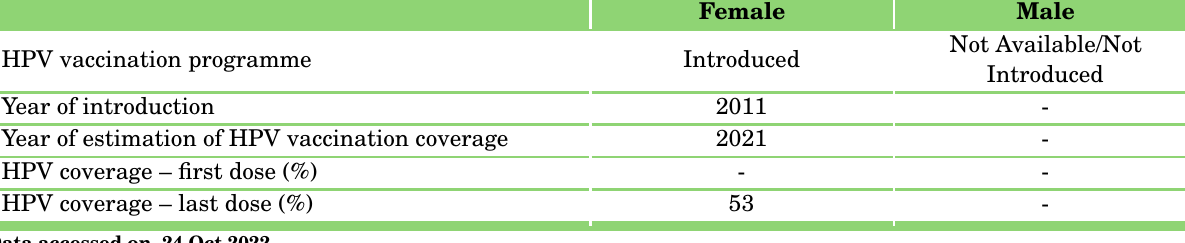
Table 46: National HPV Immunization programme in Peru